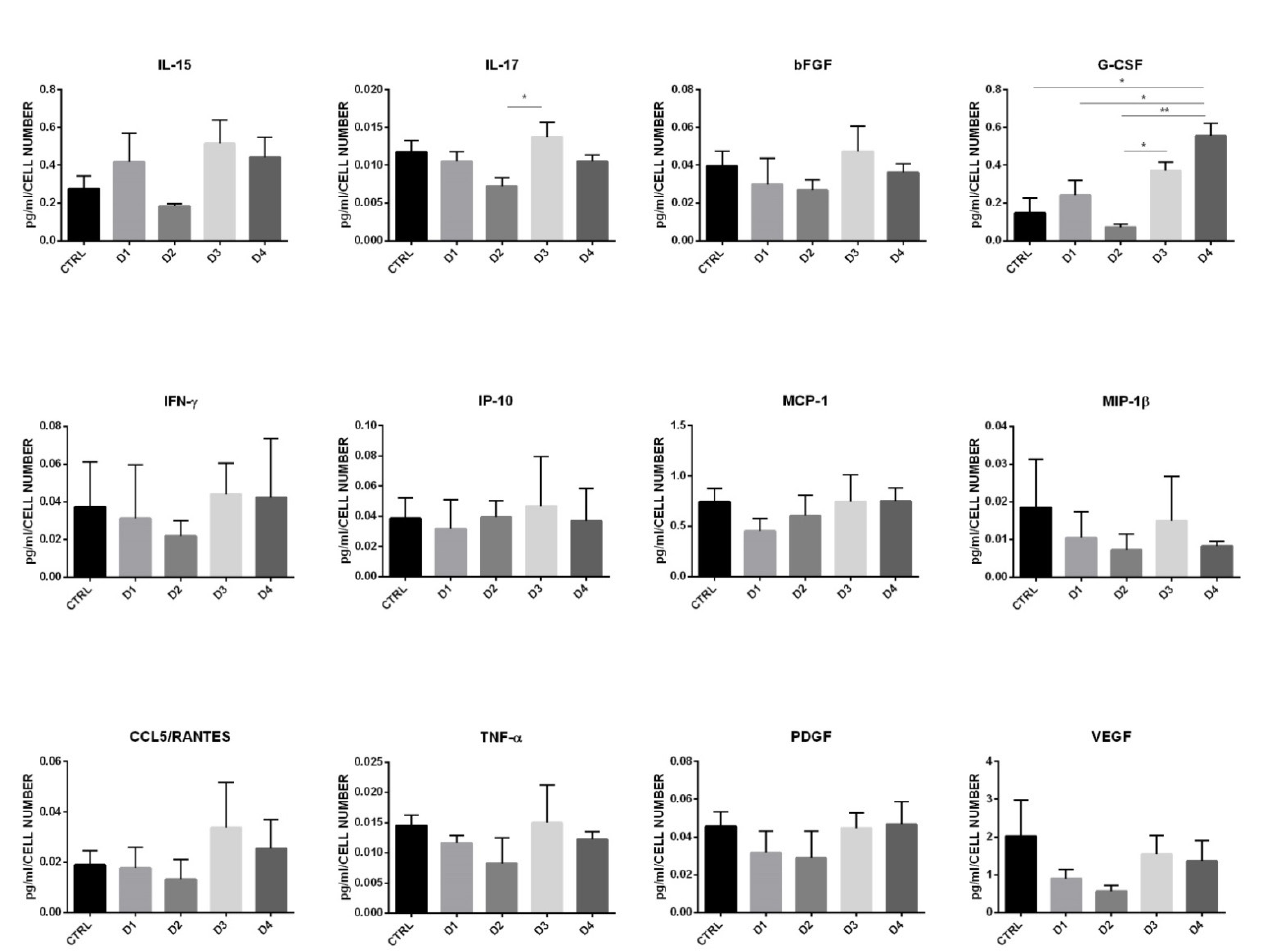
Figure 5. BFP-MSC-released cytokines, chemokines and growth factors. BFP-MSCs were plated in 12-well culture plates without disks (CTRL), on D1, D2, D3 or D4 for 72 h. Supernatants were collected and tested by using the Bio-Plex multiplex cytokine assay kit. * Denote statistical differences (* p < 0.05; ** p < 0.01).